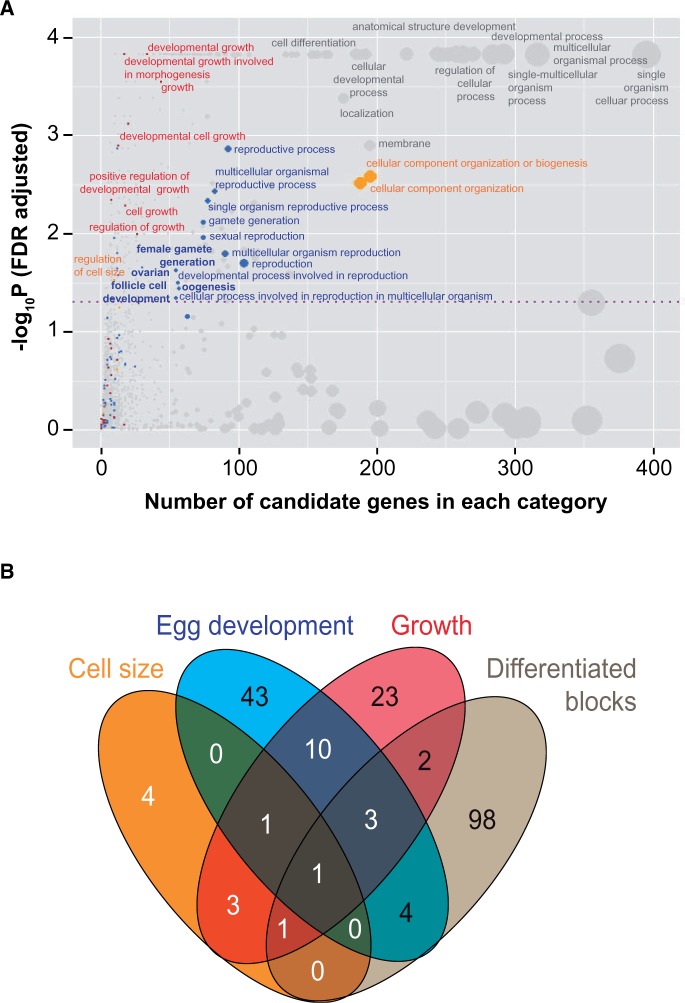
Enrichment of SDV for biologically relevant GO categories. (A) Selected set of 1,634 SDV is enriched for genes in several GO categories. On the x axis are number of genes with at least one SDV in each category and y axis indicates significance of enrichment after correcting for multiple testing. Dotted purple line indicates FDR <5%. Each dot is a GO category and size of the dots indicates the total number of genes in each GO category. Dots in gray: Broad GO categories containing several specialized GO terms; dots in blue, red, and orange: GO categories associated with reproduction (and egg development), growth, and cell size, respectively. (B) Overlap of genes harboring the enriched SDV in GO categories associated with cell size, egg development, and growth. Genes in differentiated blocks are largely distinct from those encompassed by the differentiated blocks. All of the genes in the differentiated blocks are expressed in the Drosophila ovaries (fig. 5B).